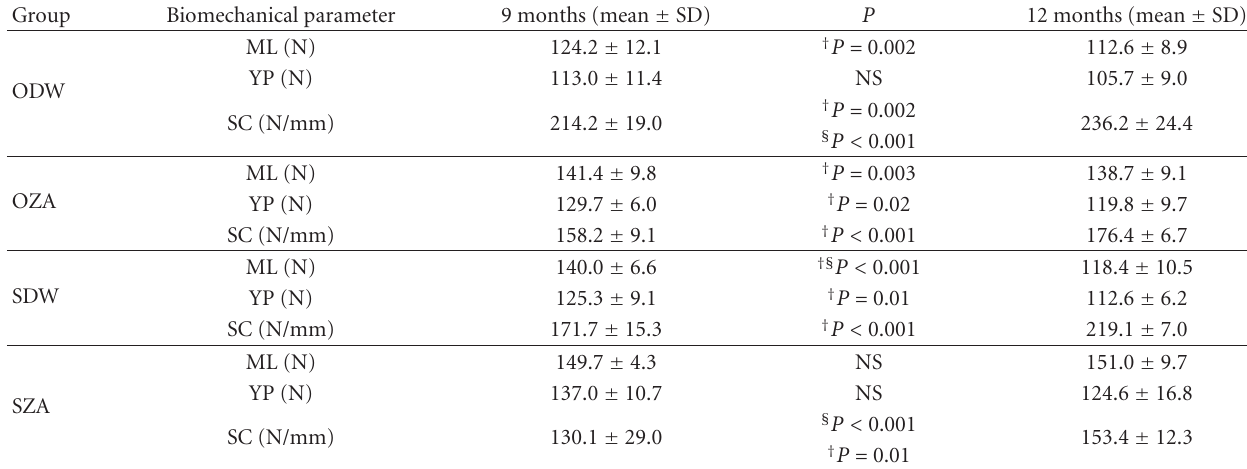
Table 4: Overview of the biomechanical parameters over